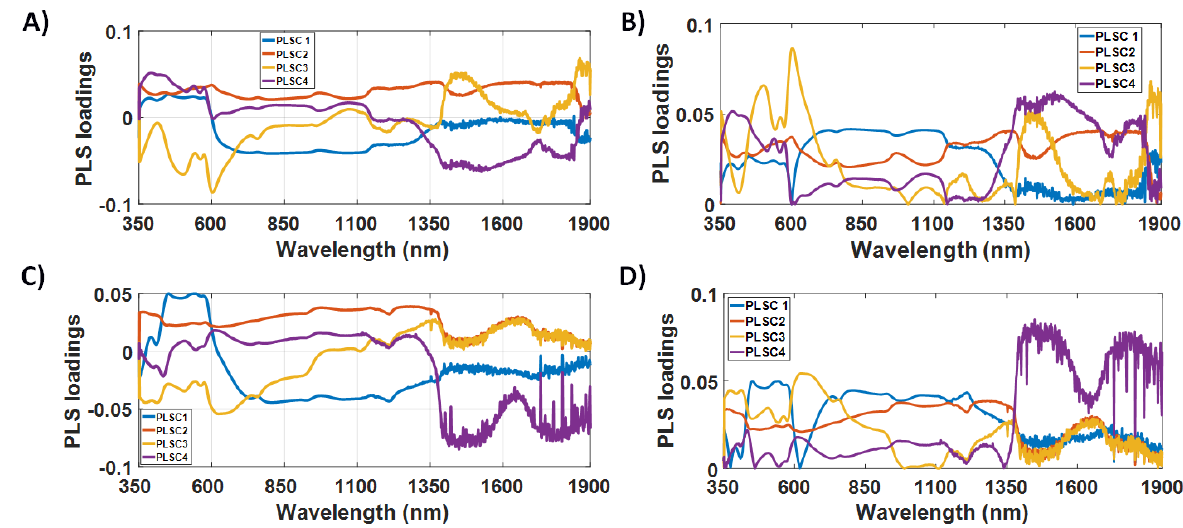
Figure 3. PLS components (PLSCs) for the classification between cancerous and mucosal/submucosal tissues. ( A ) Raw and ( B ) absolute values of PLSC loadings for the short-SDD probe and ( C ) Raw and ( D ) absolute values of PLSC loadings for the long-SDD probe.